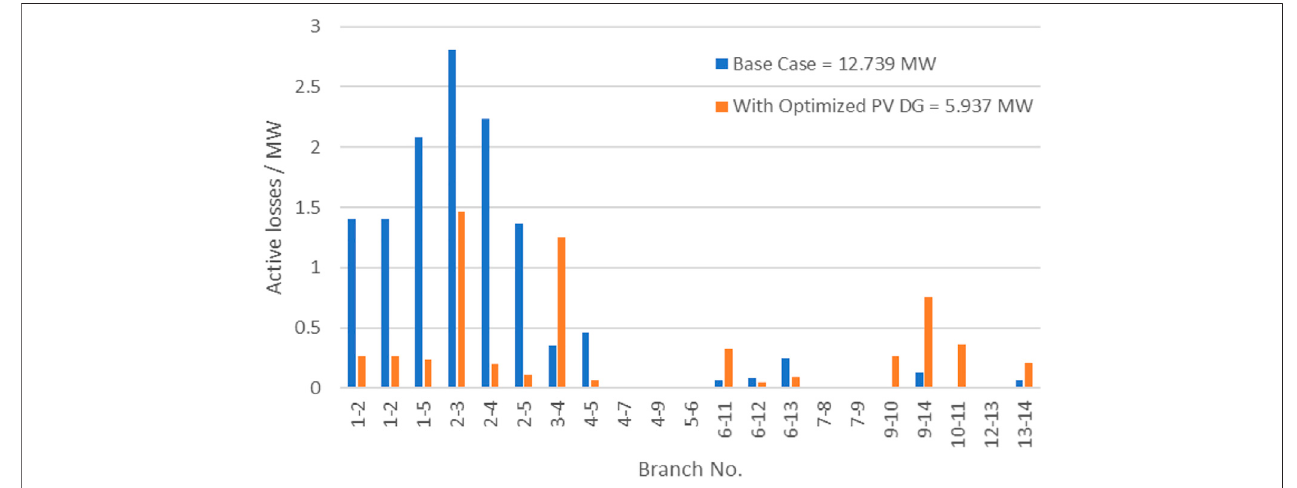
FIGURE 5 | System loss comparison for the IEEE 14 bus